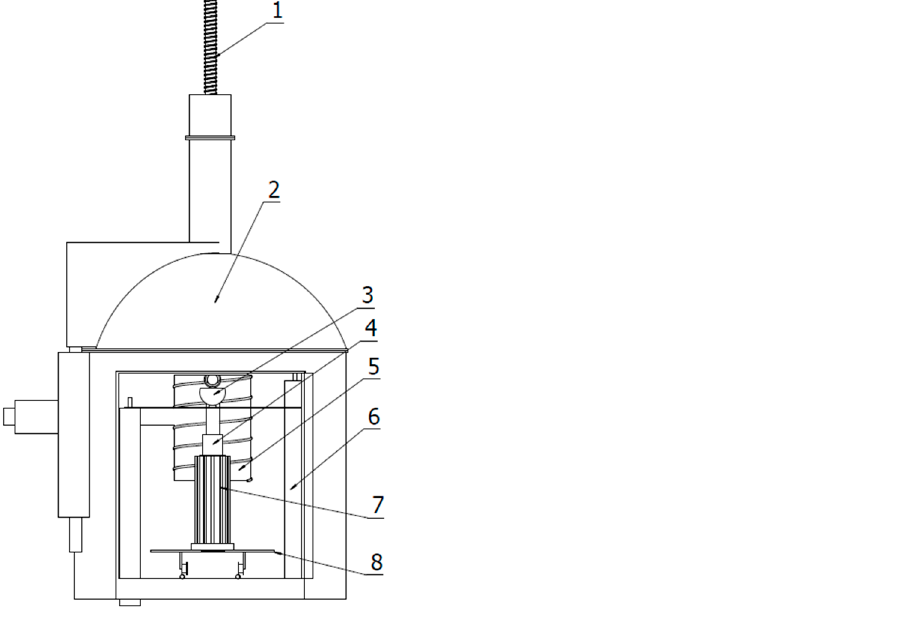
Figure 1. Schematic view of vacuum melting casting system: 1, stirring rod; 2, vacuum furnace; 3, flow groove; 4, feeder; 5, crucible; 6, frame; 7, permanent mold; 8, trolley.